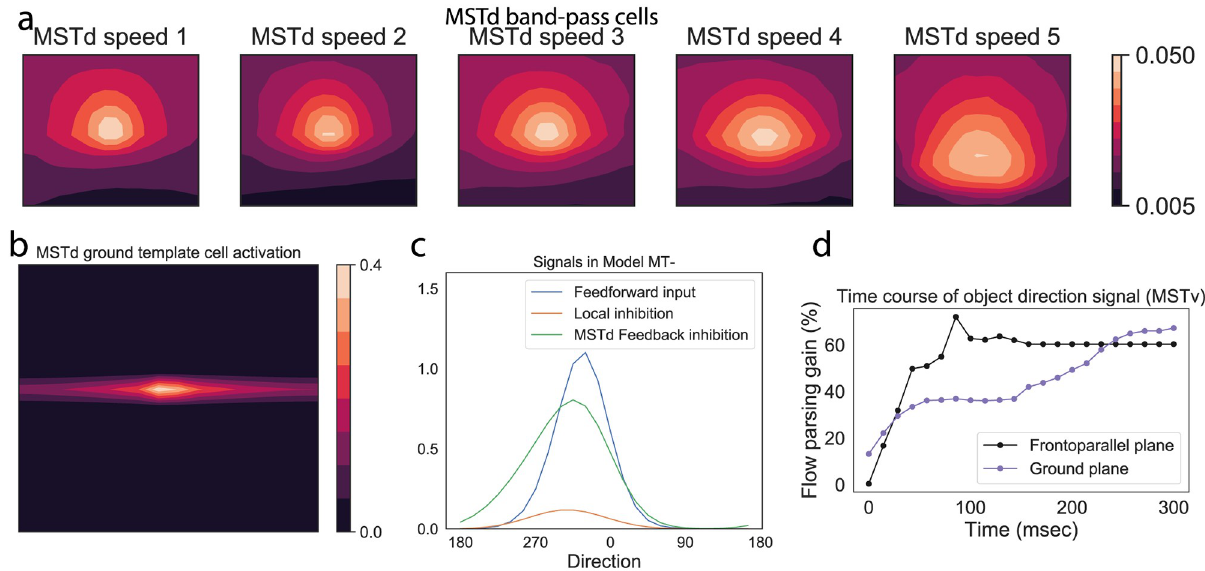
Fig 9. Model results for ground plane scenario (Simulation 2). (a) MSTd band-pass cell activity. (b) MSTd ground unit activity. (c) Excitatory and inhibitory signals integrated by MT units that process object motion. (d) Time course of the shift in the object direction signal represented in the model MSTv toward the world-relative direction. Black curve (frontoparallel plane) reproduced from Fig 6c. Blue curve corresponds to simulation of 4˚ object ground plane condition.